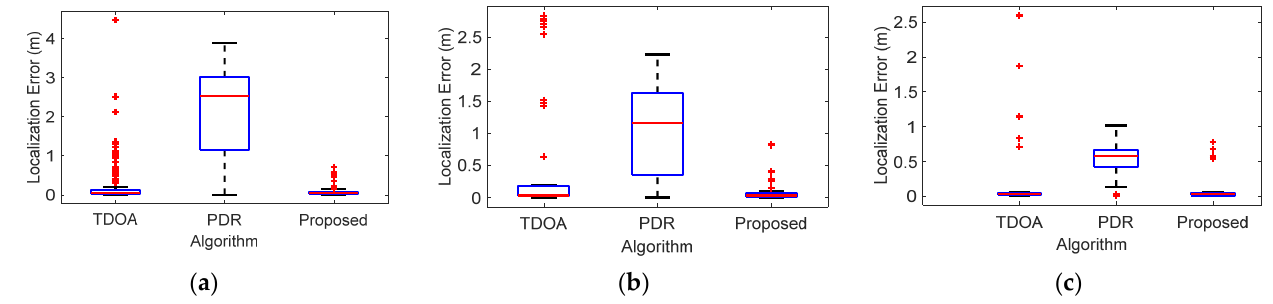
Figure 16. Localization error with TDOA algorithm, PDR algorithm and the proposed algorithm at different scenes. ( a ) First scene, ( b ) Second scene, ( c ) Third scene.